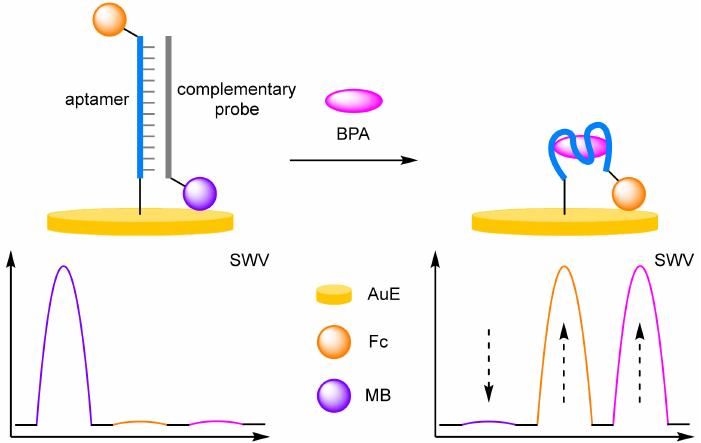
Figure 7. Schematic representation of an aptamer-based biosensor for the detection of bisphenol A (BPA) utilising the redox activity of